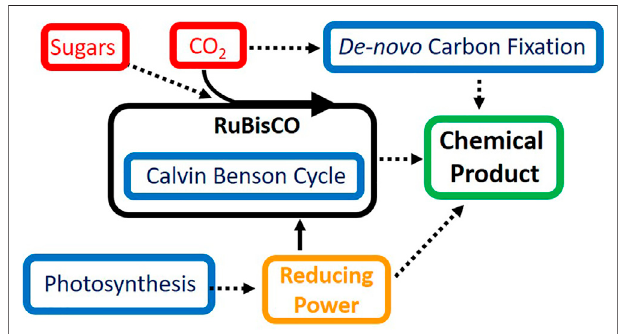
FIGURE 1 | Strategies for improving ef fi ciency of carbon fi xation and photosynthesis in cyanobacteria. Shown in red are carbon sources for metabolism in cyanobacteria, in blue are pathways of interest to synthetic biologyandmetabolicengineering, solidlinesrepresentnativepathways and dashed lines represent pathways of interest for improvement using synthetic